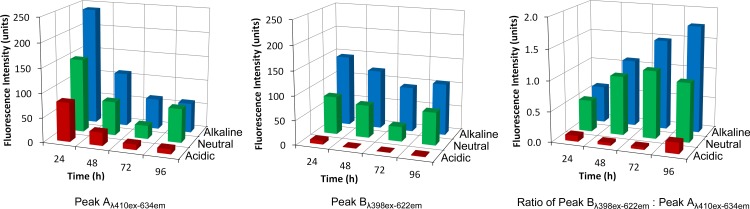
Peak fluorescence values at different pH over time in suspensions of P. intermedia.a) Peak A410:634. b) Peak B398:622. c) Ratio of Peak B398:622 / Peak A410:634.